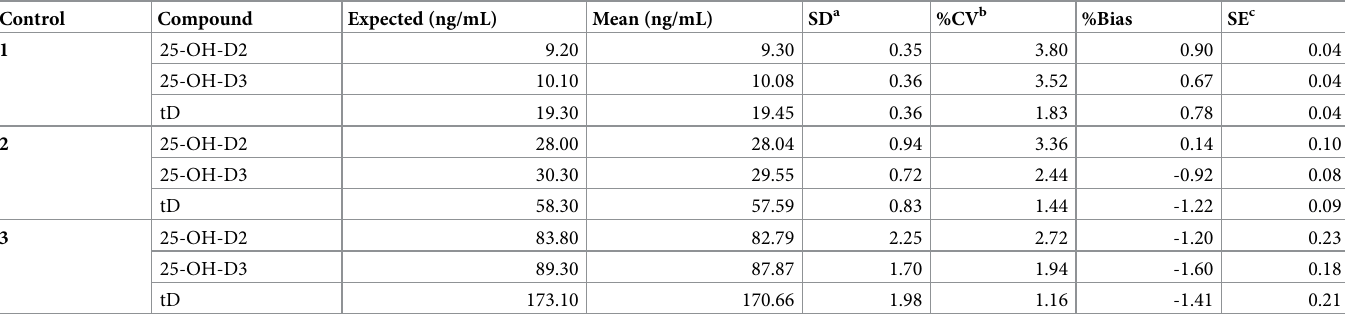
b Coefficient variance percentage. c Standard error.